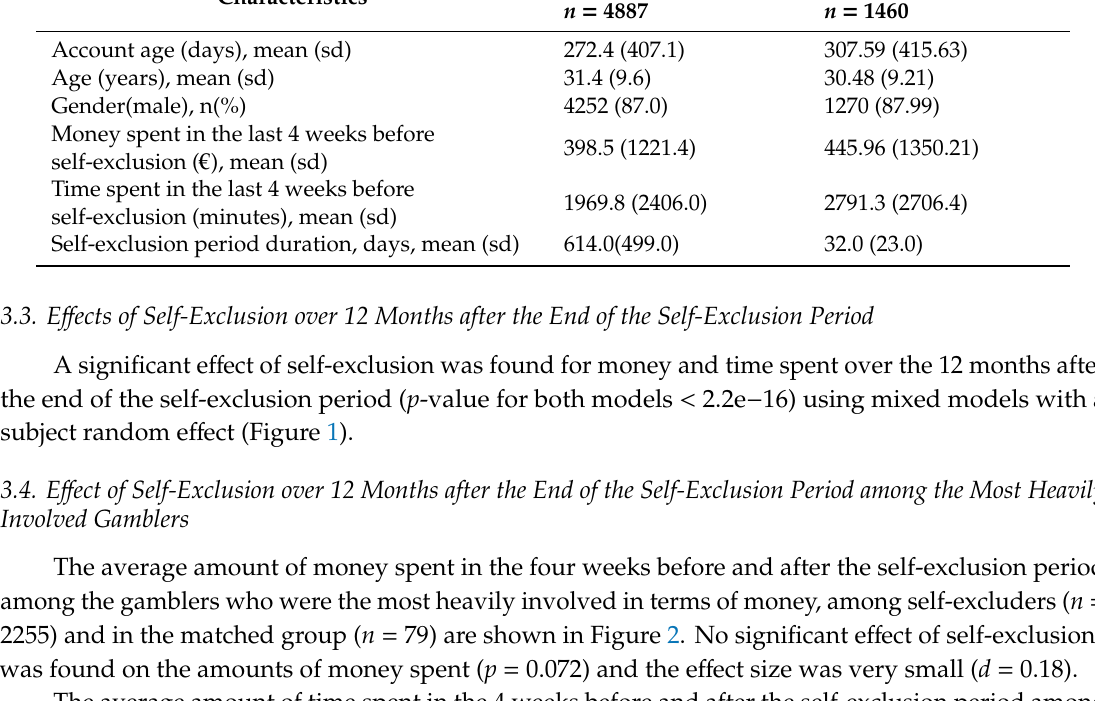
Table 1. Characteristics of first-time self-excluders, and short-duration first-time self-excluders subgroup. All 1 st Self-Exclusions Characteristics n =